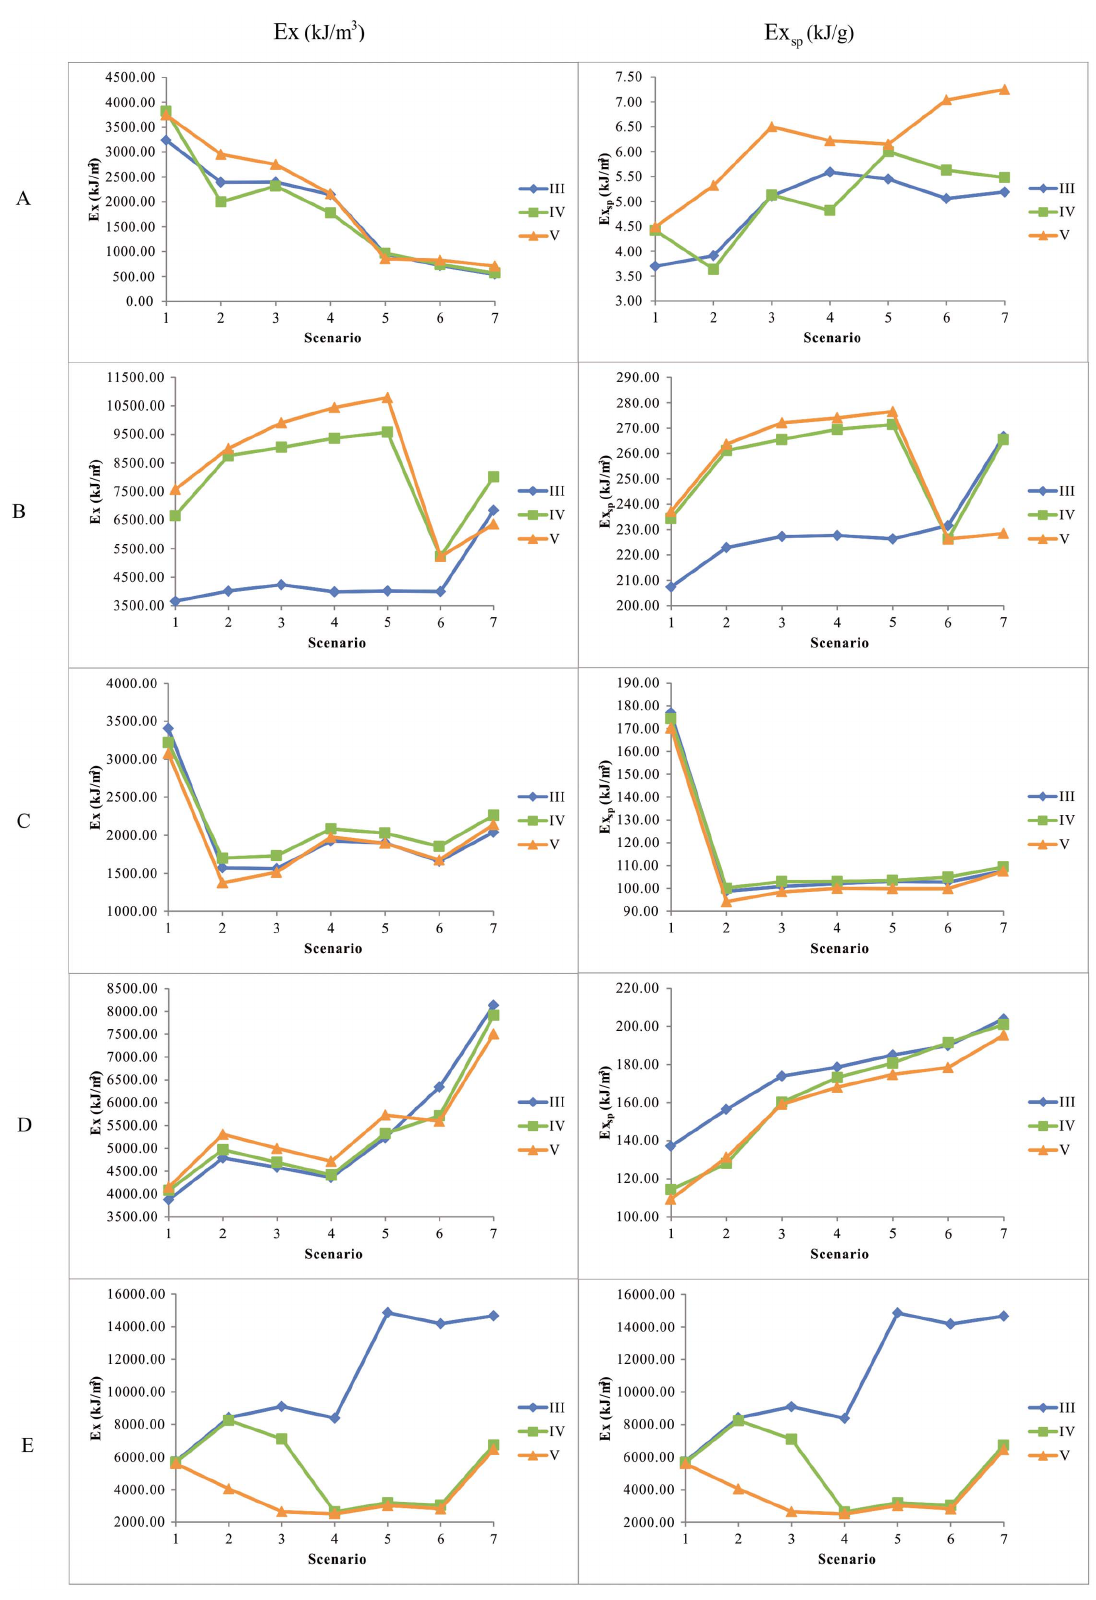
Figure 9. Eco-exergy and special eco-exergy in five regions. Eco-exergy and special eco-exergy in 7 water level scenarios and 3 water quality scenarios in region A, B, C, D and E.